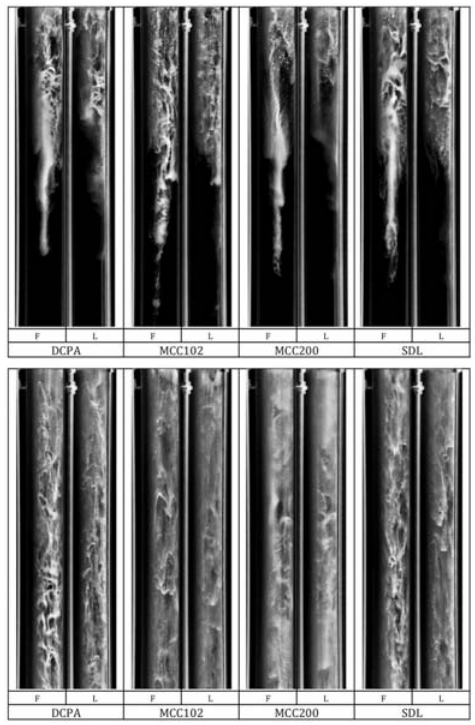
Figure 5. Close-up photographs of the powder fall (upper 1/3 of the pipe). The top row photographs show the powder plug in the verti- cal pipe with an open outlet, while the bottom row are photographs of the powder plug released into the air (condition without the pi- pe). The presented images include frontal (F) and lateral (L) views of the tested materials: dicalcium phosphate anhydrous (DCPA), microcrystalline cellulose MCC102 and MCC200, and spray-dried lactose (SDL). The original images are inverted and the contrast en- hanced for illustration